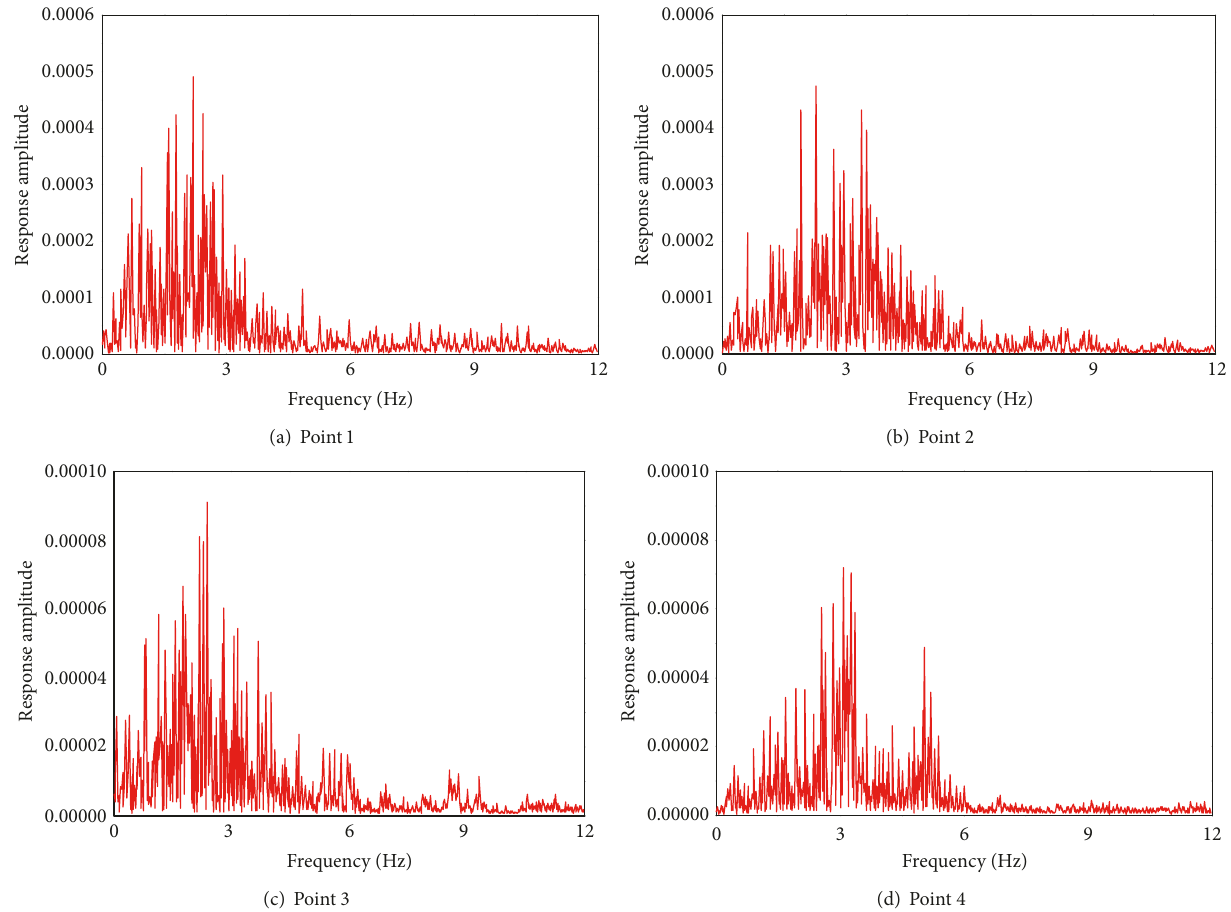
Figure 7: Dynamic responses of observed points on the masonry structure in